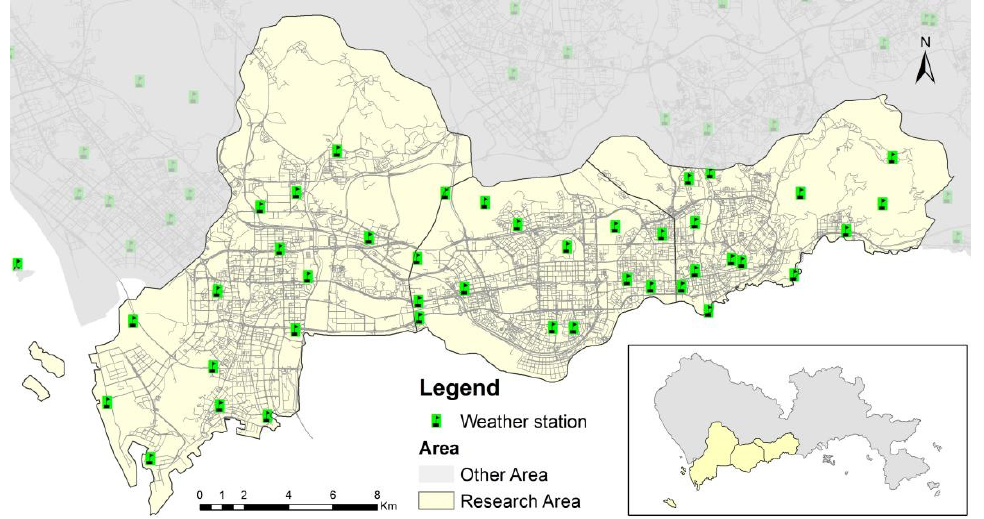
Figure 1. Research area.